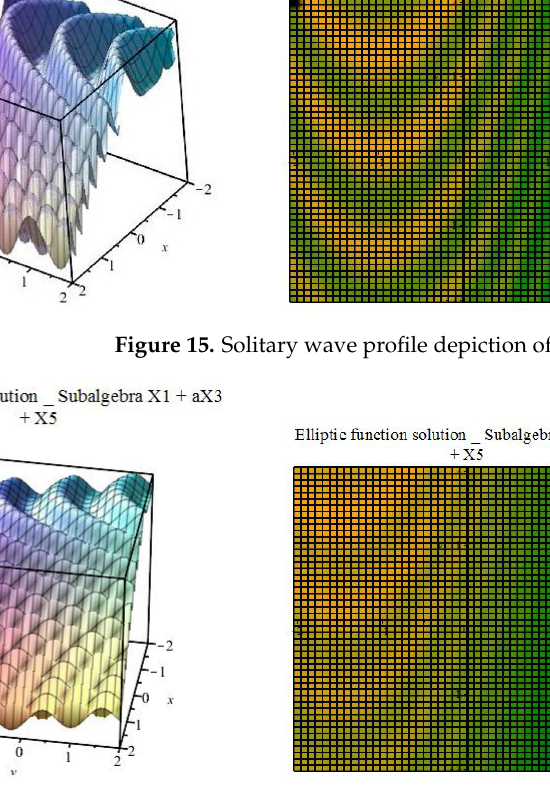
Figure 16. Solitary wave profile depiction of elliptic solution (84) at t =